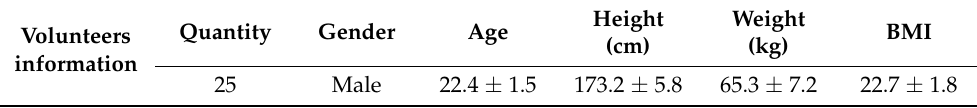
Table 1. Relevant subject information.